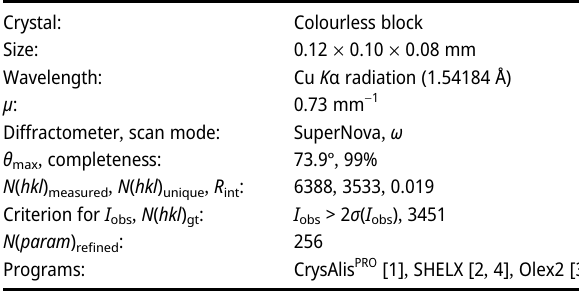
Table  : Data collection and